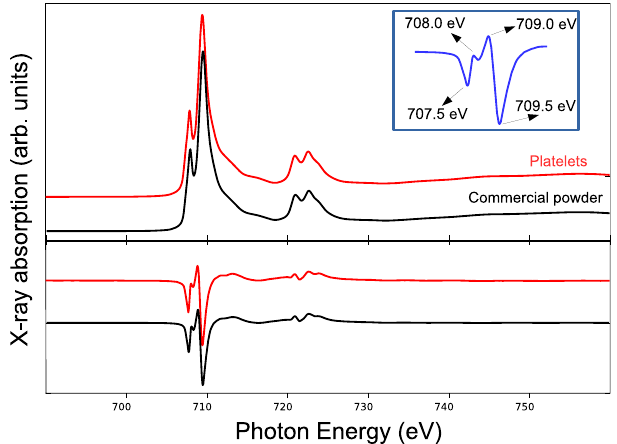
Figure 6. X-ray absorption spectra at the Fe L 2,3 absorption edges recorded from the platelets and the commercial powder, they were acquired at 2 K under an applied field of 6T and averaged for both light helicities. Bottom: x-ray magnetic circular dichroism spectra for both temperatures obtained by subtracting the spectra acquired with opposite light helicities. Inset: Energy positions for each of the peaks observed in the Fe L 2,3 edge XMCD